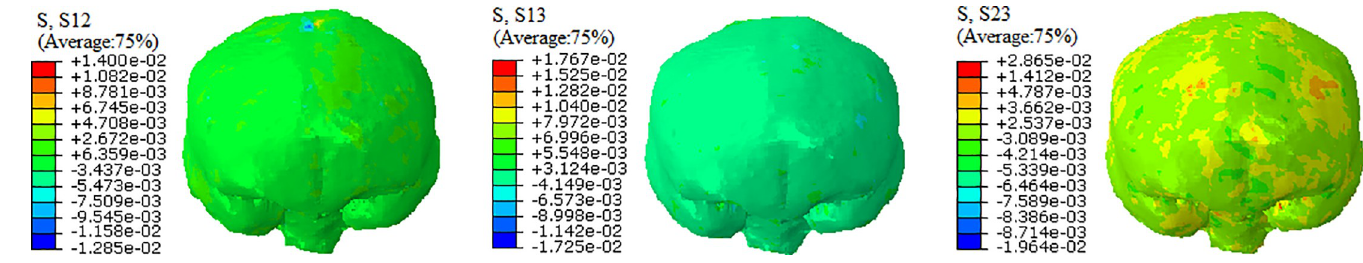
Fig 16. Shear stress of frontal brain tissue. (A) XY plane. (B) XZ plane. (C) YZ